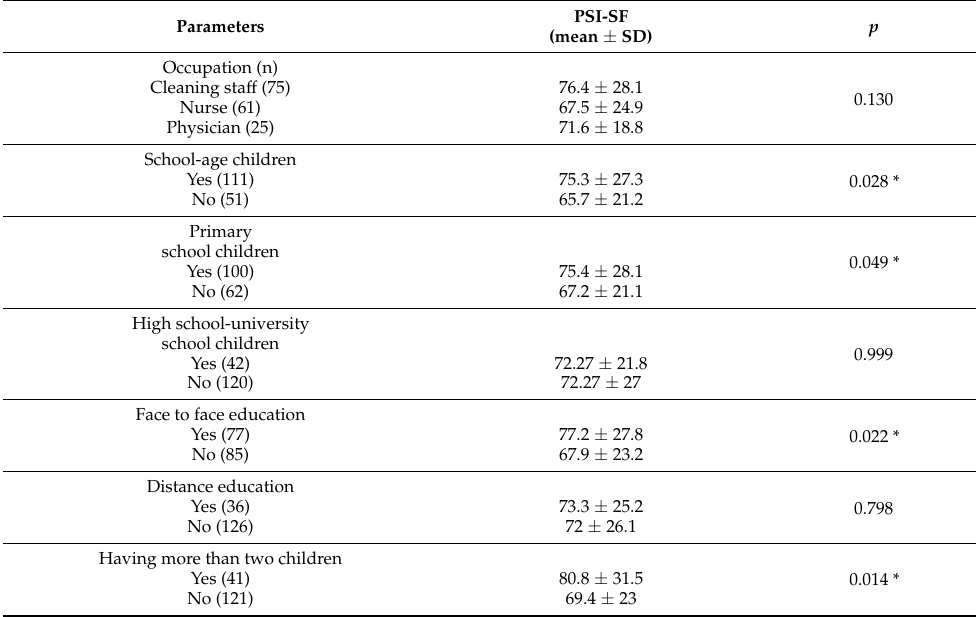
Table 3. Results of multinominal logistic regression analysis were summarized in Table 4. The parameters affecting the PSI-SF subscale scores are summarized in Table 5. Table 3. Parameters affecting total PSI-SF